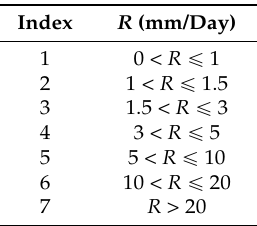
Figure 8. Probability Density Function by occurrence (PDFc) of daily precipitation (mm/day) for cases with different intensities over contiguous China and seven sub-regions for ( a ) China; ( b ) XJ; ( c ) TP; ( d ) NW; ( e ) NE; ( f ) NC; ( g ) SW; and ( h ) SC. Only grid cells where there is at least one reporting gauge and both the reference and the satellite-based precipitation estimates are nonzero can be selected for computing the occurrence. Table 2. Thresholds for precipitation